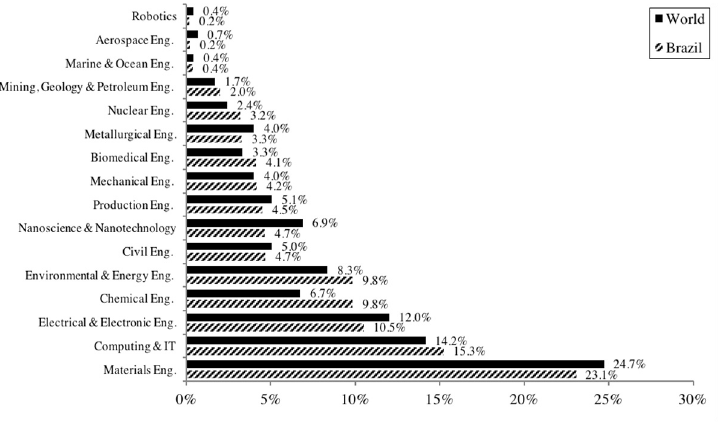
Figure 5. Global vs Brazilian distribution (by fi eld) of quali fi